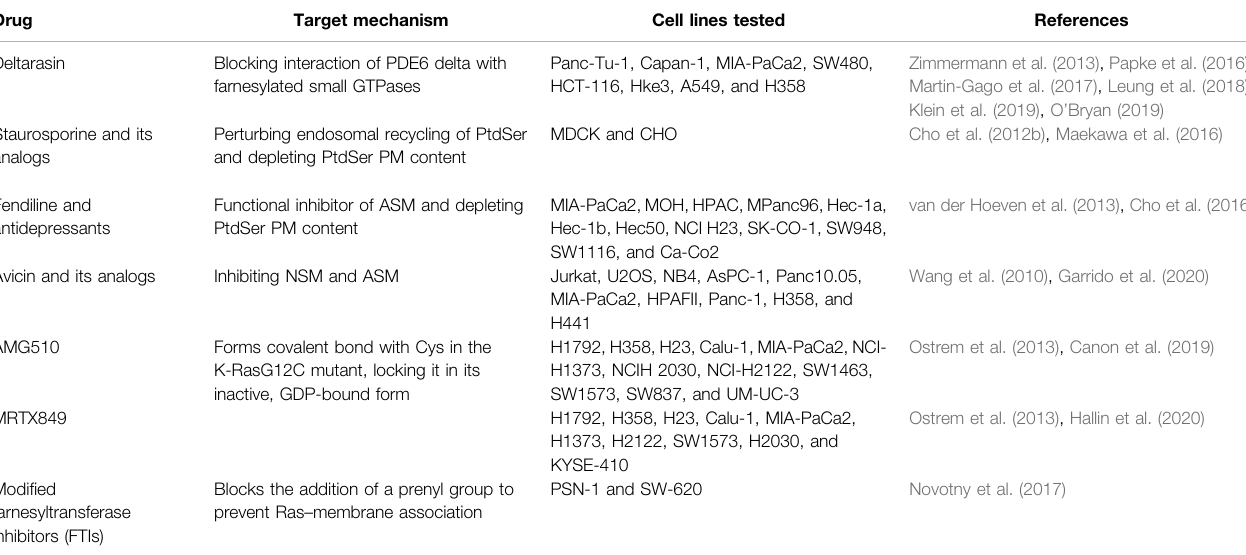
TABLE 1 | Summary of the compounds that inhibit K-Ras interaction with the